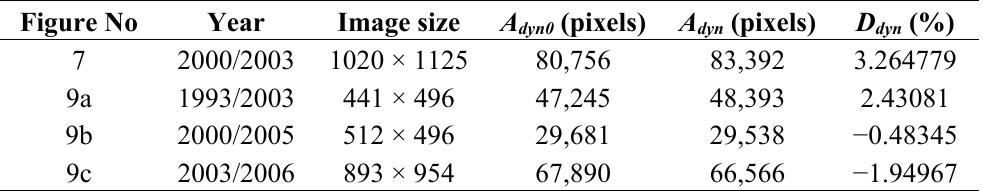
Table 3. Assessment of accuracy of detecting vegetation change. A is the area of the dynamic objects after the interactive initial dynamic objects; A dyn , of D dyn